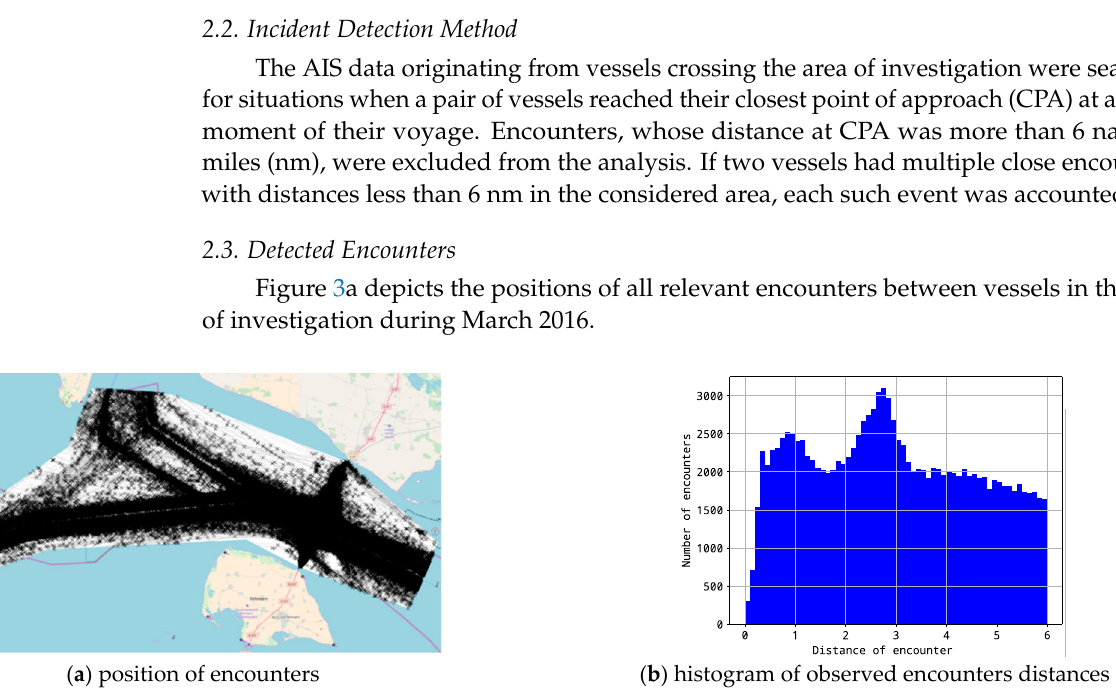
Figure 2. Database: ( a ) the polygon defining the area for the automatic identification system (AIS) data analysis and ( b ) the major shipping routes derived from AIS data.